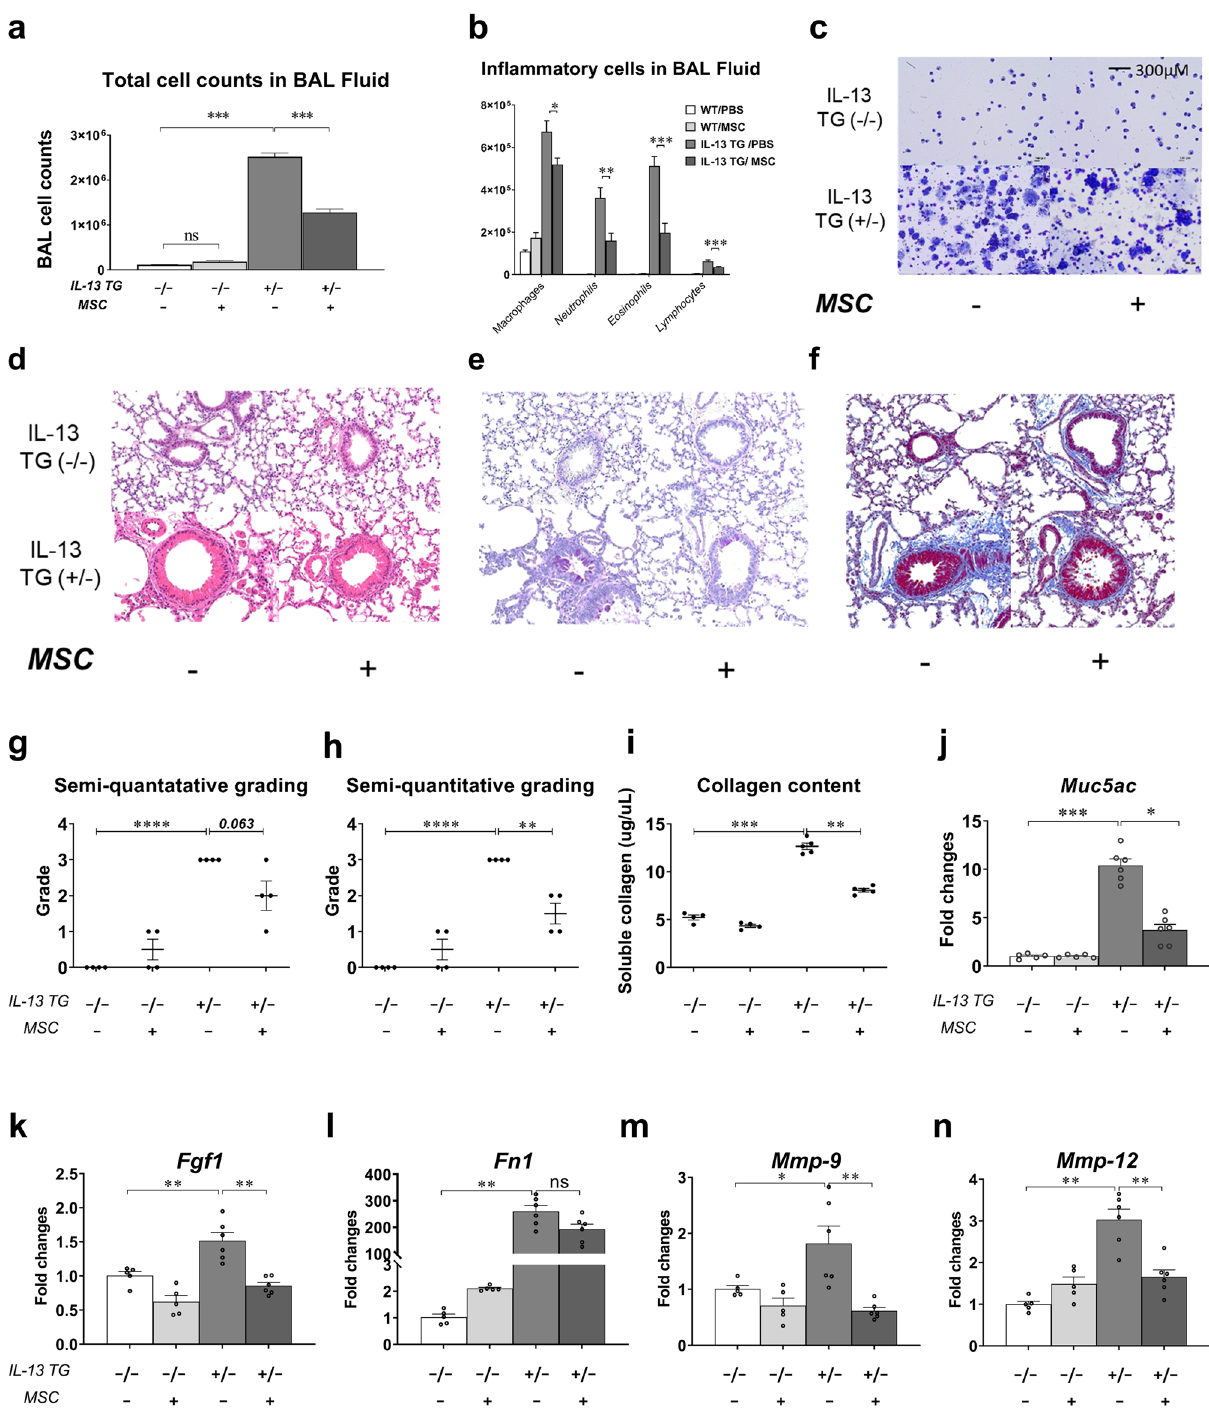
Figure 1. Liproxstatin-1-primed hUC-MSCs alleviated airway inflammation mitigated pulmonary fibrosis in vivo . ( a ) Shows the result of total cell counts and ( b ) shows differential counts of macrophages, neutrophils, eosinophils, and lymphocytes in BAL fluid. ( c ) Shows microscopic images of Diff-Quick-stained slides of cytocentrifuged BAL fluid (× 40). Samples from IL-13 TG groups were diluted with doubled amount of PBS compared with the samples from the wild type groups. ( d – e ) shows histological comparison between the groups at a power of 20. H&E ( d ) and PAS ( e ) stains were used. ( f ) Shows Masson’s Trichrome-stained slides of each group at low power (× 20). ( g – h ) shows semi-quantitative grading results of H&E staining ( g ) and PAS staining ( h ). Sircol collagen assay was performed to quantify the soluble collagen contents in the homogenates of the lungs ( i ). ( j – n ) represents relative gene expressions of Muc5ac (j) , Fgf1 (k) , Fn1 (l) , Mmp-9 (m) , and Mmp-12 (n) compared to the housekeeping, Gapdh. Each value in these panels is from a different individual and the mean ± SEM are illustrated. All results are representative of at least three independent experiments. *p < 0.05, **p < 0.01, ***p < 0.001, ****p < 0.0001, ns not significant. (by Kruskal–Wallis test using GraphPad Prism 7, https:// www. graph pad.